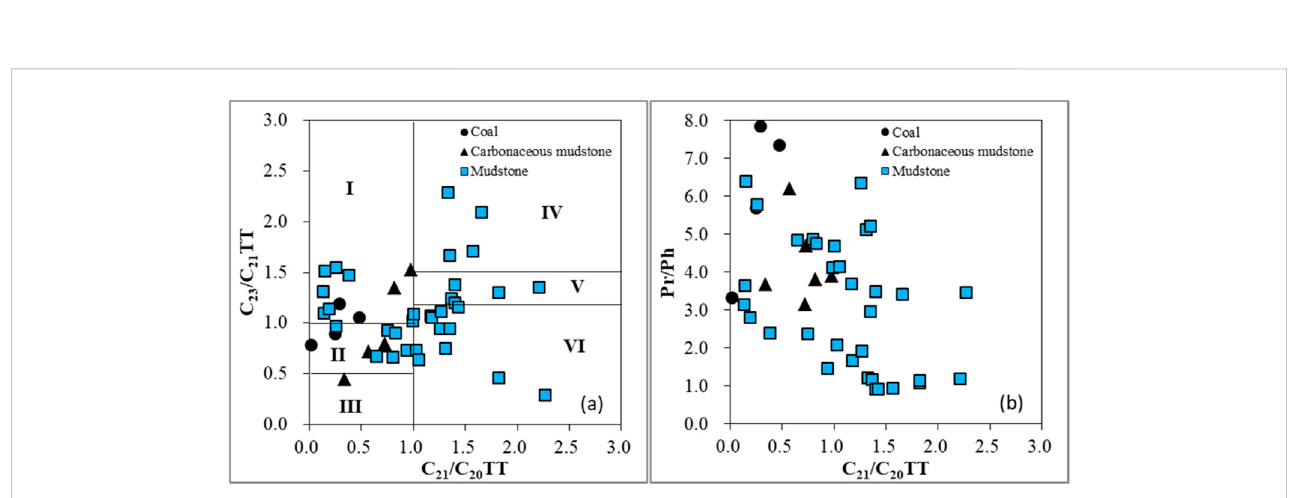
Cross-plots of C 23 /C 21 TT vs. C 23 /C 21 TT (A) and C 21 /C 20 TT vs. Pr/Ph (B) in the Pingbei area, East China Sea Basin. Note: TT= tricyclic terpane; Pr/Ph = pristane/phytane; I: Marine-continental transitional facies; II: River-lake transitional facies; III: Terrigenous source; IV: Marine facies;V: Saline lacustrine facies or marine facies; VI: Brackish-freshwater lacustrine